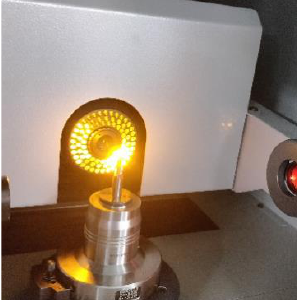
Figure 8. Tool testing on Zoller.